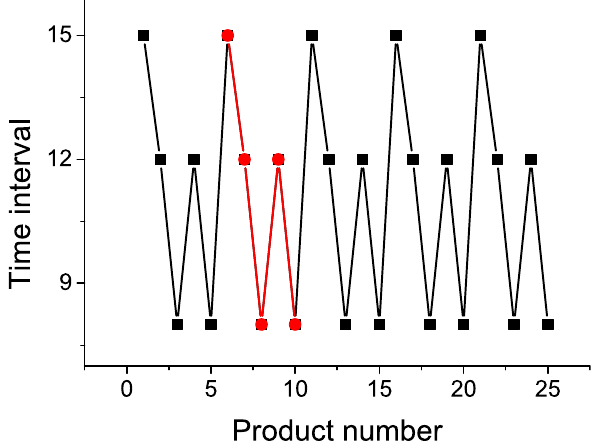
Figure 2. If supply is stationary with τ s = 11 beats, intervals τ P between two successive releases of product particles will be [-15-12-8-12-8-]…; repeated fragment is shown in